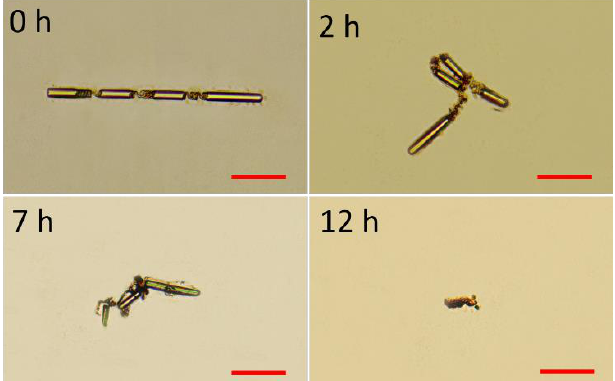
Figure 3. Degradability test of the fabricated microswimmer at different time instants. The scale bar is 50 μm for all images.